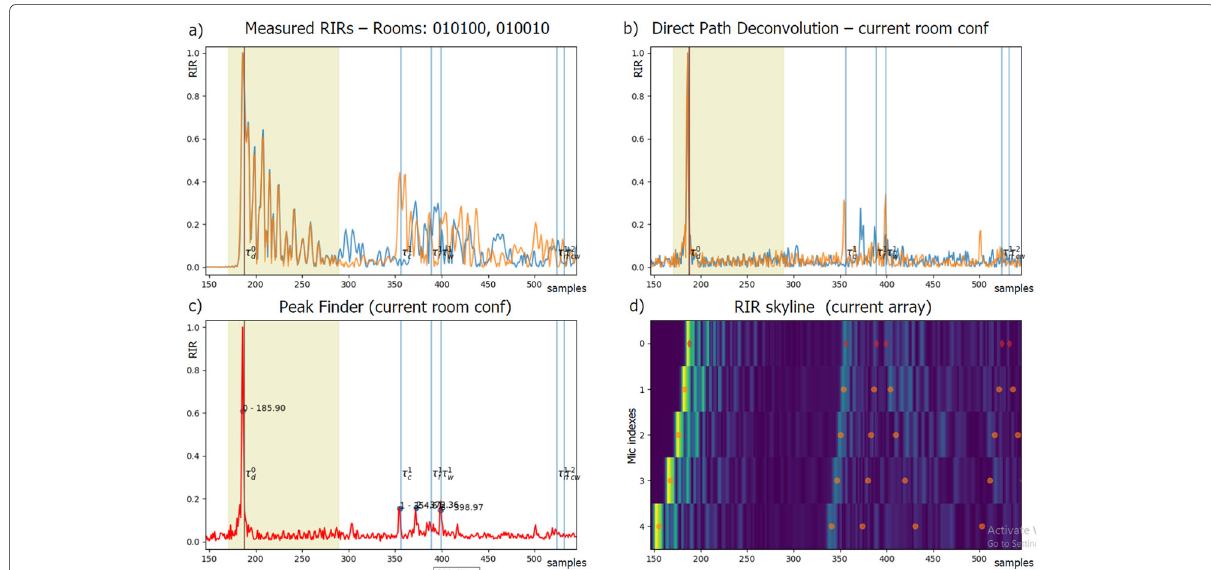
Fig. 5 Detail of the GUI used to manually annotate the RIRs. For a given source and a microphone in an nULA, a and b show 2 RIRs for 2 different room configurations (blue and orange) before and after the direct path deconvolution. c The results of the peak finder for one of the deconvolved RIRs. d A detail on the RIR skyline (see Fig. 6) on the corresponding nULA, transposed to match the time axis